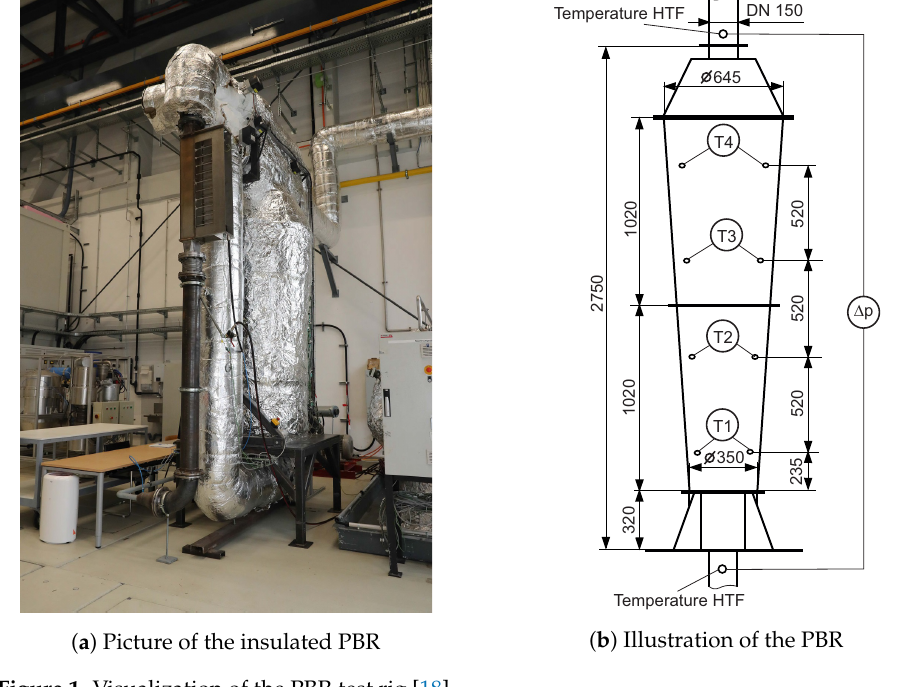
Figure 1. Visualization of the PBR test rig